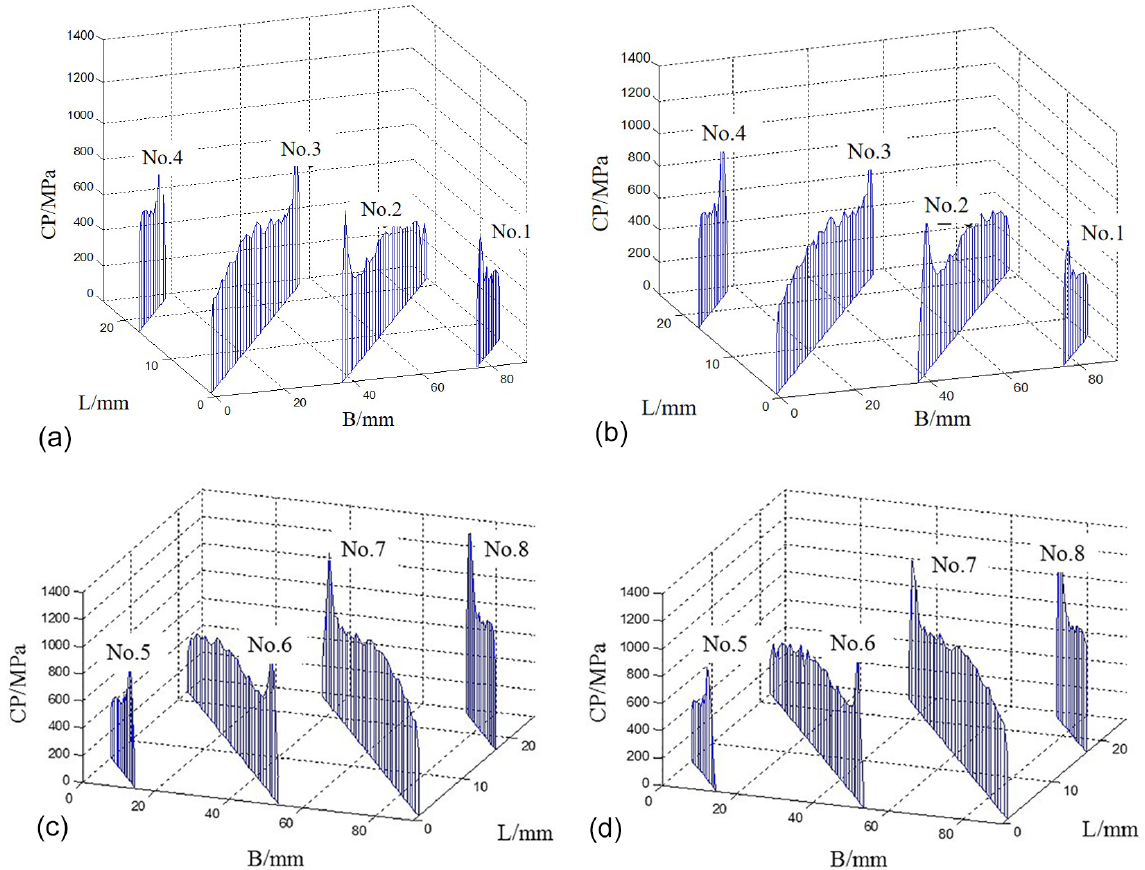
Figure 14. Contact stress distribution of the herringbone gear system with two different power flows. (a) The left tooth surface of the U - shaped power flow. (b) The left tooth surface of the Z -shaped power flow. (c) The right tooth surface of the U -shaped power flow. (d) The right tooth surface of the Z -shaped power flow. Table 2. Contact stress of left and right tooth surfaces with different power flow directions. Mesh cycle ( T ) U -shaped power flow Z -shaped power flow maximum contact stress (MPa) maximum contact stress (MPa) Left Right Difference Left